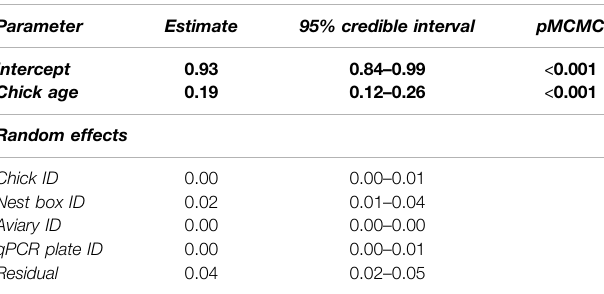
TABLE 1 | Results from a Bayesian MCMC linear mixed-effects model testing the difference between telomere length in house sparrow chicks at 0.5 and 3 months of